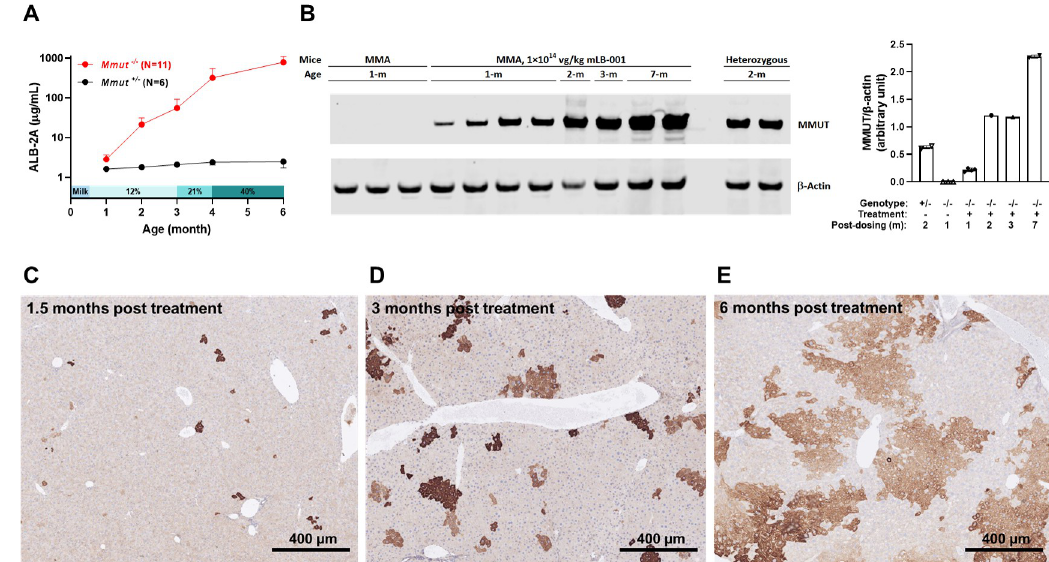
Fig 3. MMUT protein expression in mice treated with 1 × 10 14 vg/kg mLB-001 at PND 1. (A) Plasma ALB-2A levels remained stable in all heterozygous ( Mmut +/- ) animals while showing an exponential increase over time in all MMA ( Mmut -/- ) mice. (B) Immunoblot analysis of MMUT protein in the liver tissues. Vehicle-treated heterozygous and MMA mice were used as positive and negative controls for protein expression. β -actin was used as a loading control. (C-E) Immunohistochemistry analysis of MMUT protein expression in livers of three mLB-001-treated MMA mice sacrificed at 1.5- (C), 3- (D), and 6- (E) months post- dosing. The scale bars represent 400 μ m.